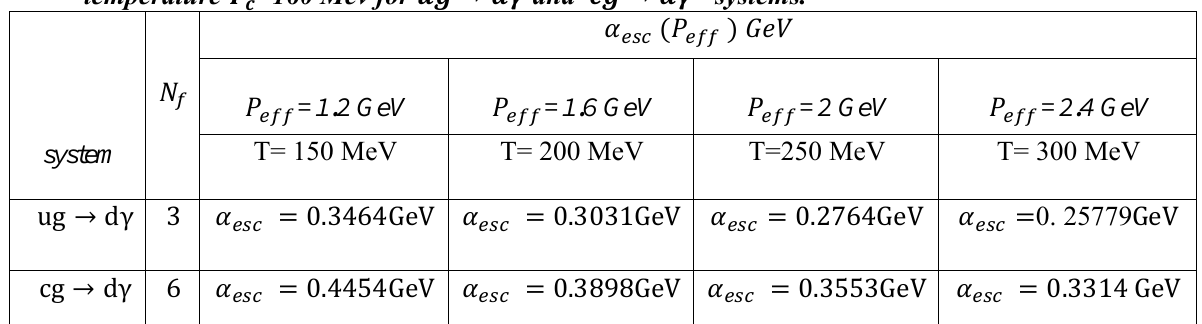
due to critical (cid:2187)(cid:2201)(cid:2185)